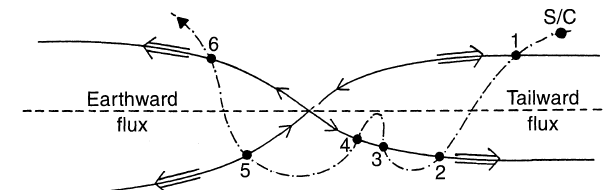
Fig. 14. The combined e(cid:128)ect of neutral-sheet flapping during the interval 16:45–18:20 UT of day 73, 1993 and a tailward-moving X- type magnetic field line is given in this sketch illustrating the GEOTAIL (S/C) trajectory. The six successive crossings of the PSBL occurred at (cid:24) 180 R and are characterized by streaming ions in a E direction emphasized by large arrows . The first crossing occurred just after the substorm onset at (cid:24) the sketch of Fig. 14. The large arrows show the direction of streaming ions, while the solid ones deter- mine the separatrices. The Earthward-streaming ions are associated with closed magnetic field lines, while the